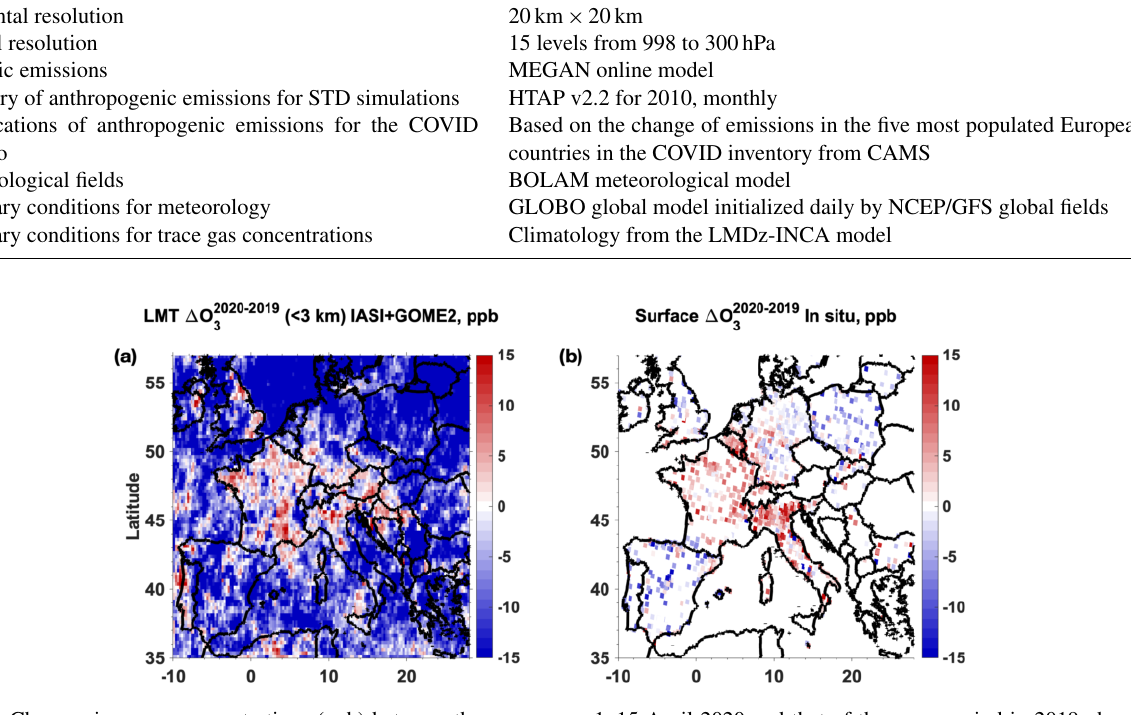
Figure 1. Changes in ozone concentrations (ppb) between the average on 1–15 April 2020 and that of the same period in 2019 observed (a) at the lowermost troposphere (below 3km of altitude) by the IASI + GOME2 multispectral satellite approach and (b) at the surface by in situ sensors from the EEA network. The temporal and spatial sampling of both datasets is the same, only considering in situ data coincident in time and space with the satellite retrievals (on a daily